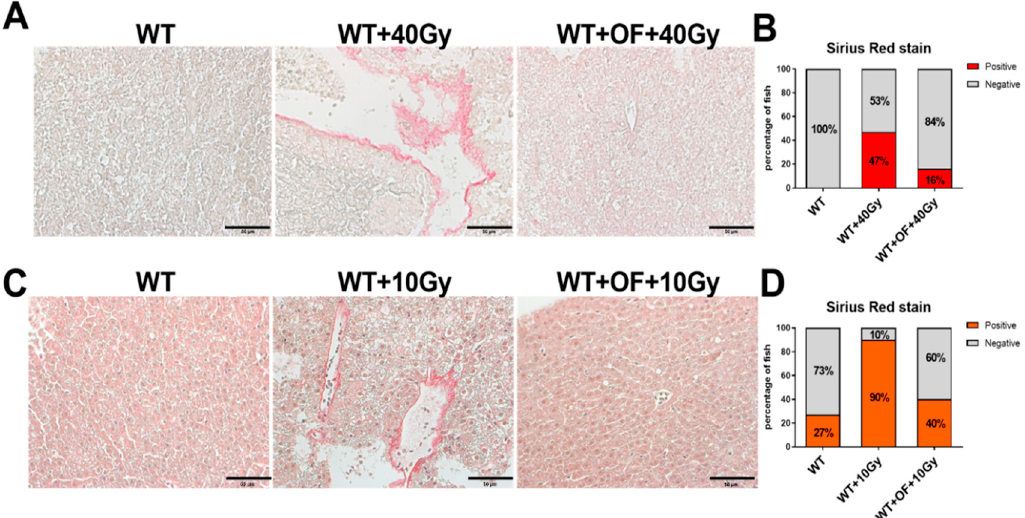
Figure 2. Sirius red staining in adult zebrafish treated with Oligo-Fucoidan and radiation. ( A ) The representative images of Sirius red staining of wild-type fish without irradiation (WT), with 40 Gy irradiation (WT + 40 Gy), or treatment of Oligo-Fucoidan before 40 Gy irradiation (WT + OF + 40 Gy). The images were taken at 400 × magnification, and the scale shown is for 50 µ m. ( B ) Statistical analysis from wild-type fish treated with 40 Gy irradiation. ( C ) The representative images of Sirius red staining of wild-type fish without irradiation (WT), with 10 Gy irradiation (WT + 10 Gy) or treatment of Oligo-Fucoidan before 10 Gy irradiation (WT + OF + 10 Gy). The images were taken at 400 × magnification, and the scale shown is for 50 µ m. ( D ) Statistical analysis from wild-type fish treated with 10 Gy irradiation.